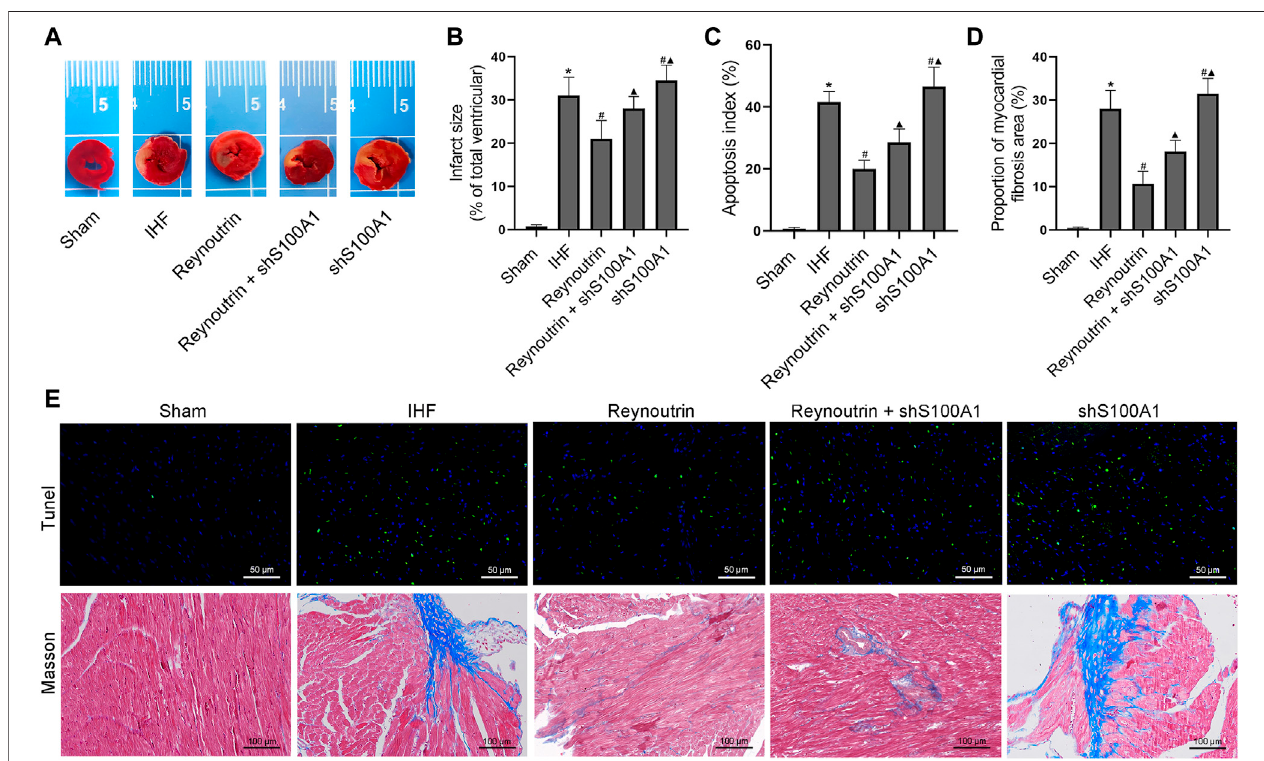
FIGURE 6| Effects ofreynoutrin and S100A1 knock-down on infarction, fi brosis and apoptosis ofmyocardium in rats. The dose ofreynoutrin here was 50 mg/kg. (A) The representative images of TTC staining of each group. (B) The histogram of infarct size in each experimental group, which in percent of the surface of the stained slices. (C) The histogram of apoptosis index in each experimental group. (D) The histogram of myocardial fi brosis area proportion in each experimental group. (E) The representative images of Masson and Tunel staining of each group. The values presented as the means ± standard error in each experiment group ( n (cid:1) 10). * p < 0.05 vs. Sham group; # p < 0.05 vs. IHF group; ▲ p < 0.05 vs. Reynoutrin